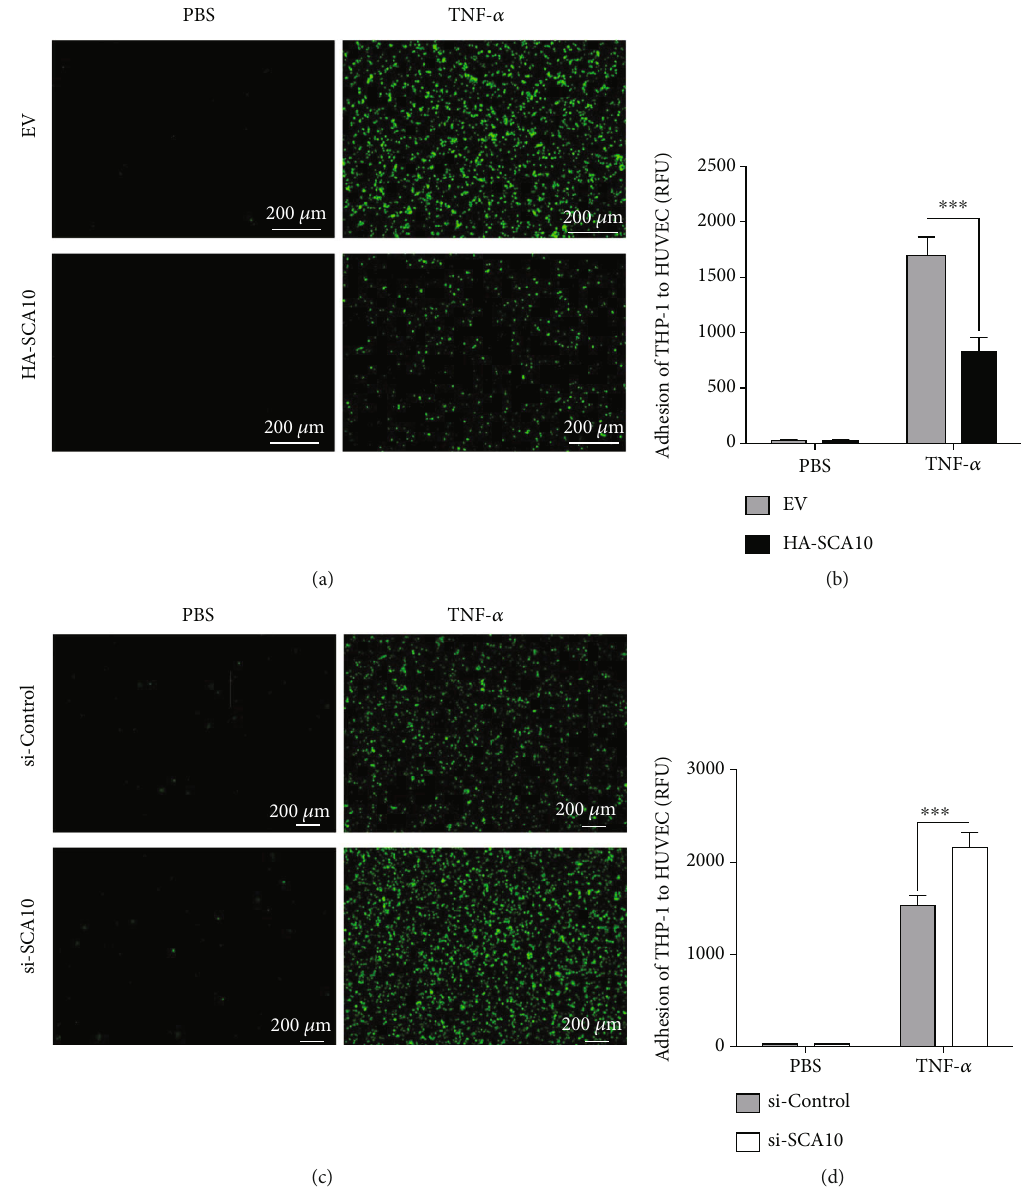
Figure 2: E ff ects of Ataxin-10 on the adhesion of THP-1 monocytes to TNF- α -treated HUVECs. (a, c) Photographs ( × 200 magni fi cation) of PKH67 fl uorescent labeled monocytes (THP-1 cells, green) adhering to HUVECs. (b, d) Quantitative data analysis revealed signi fi cant increases in adhesion of THP-1 cells to the HUVEC monolayer. The data are representative of 6 independent experiments. ∗∗∗ p < 0 : 001 vs. TNF- α treated control group. (a, b) Ataxin-10 or empty vector (EV) was transfected transiently into HUVECs; 48h later, cells were incubated with or without TNF- α (10 ng/mL) for 8 h. Then, fl uorescence-labeled THP-1 cells were added to the activated HUVECs